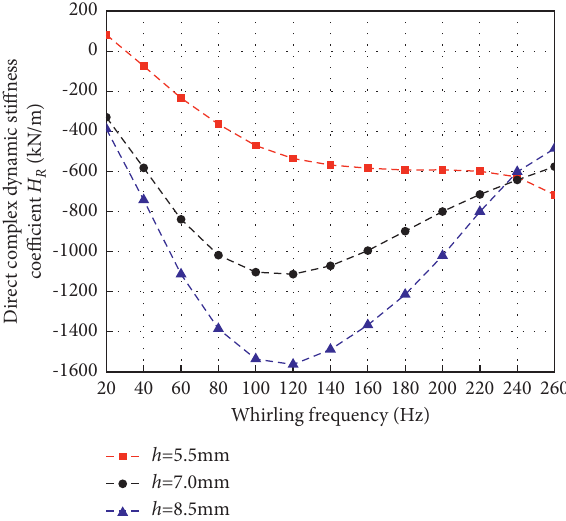
Figure 16: Direct complex dynamic stiffness coefficient vs. whirling frequency.